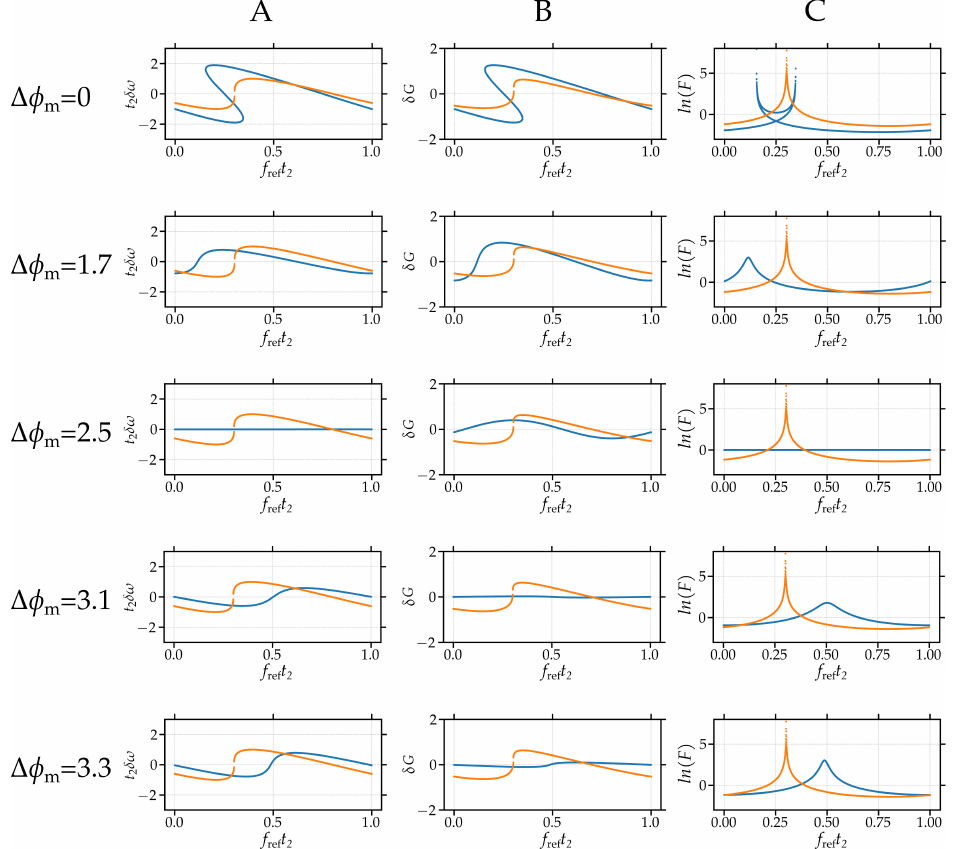
Figure 3. Numerical solutions for C = 1 under conditions (8) and (11) for different ∆ φ m . Double- feedback case shown in blue, single feedback case shown in orange. Column ( A ) shows the lasing frequency shift results. Column ( B ) shows the threshold gain shift. Column ( C ) shows the intrinsic linewidth